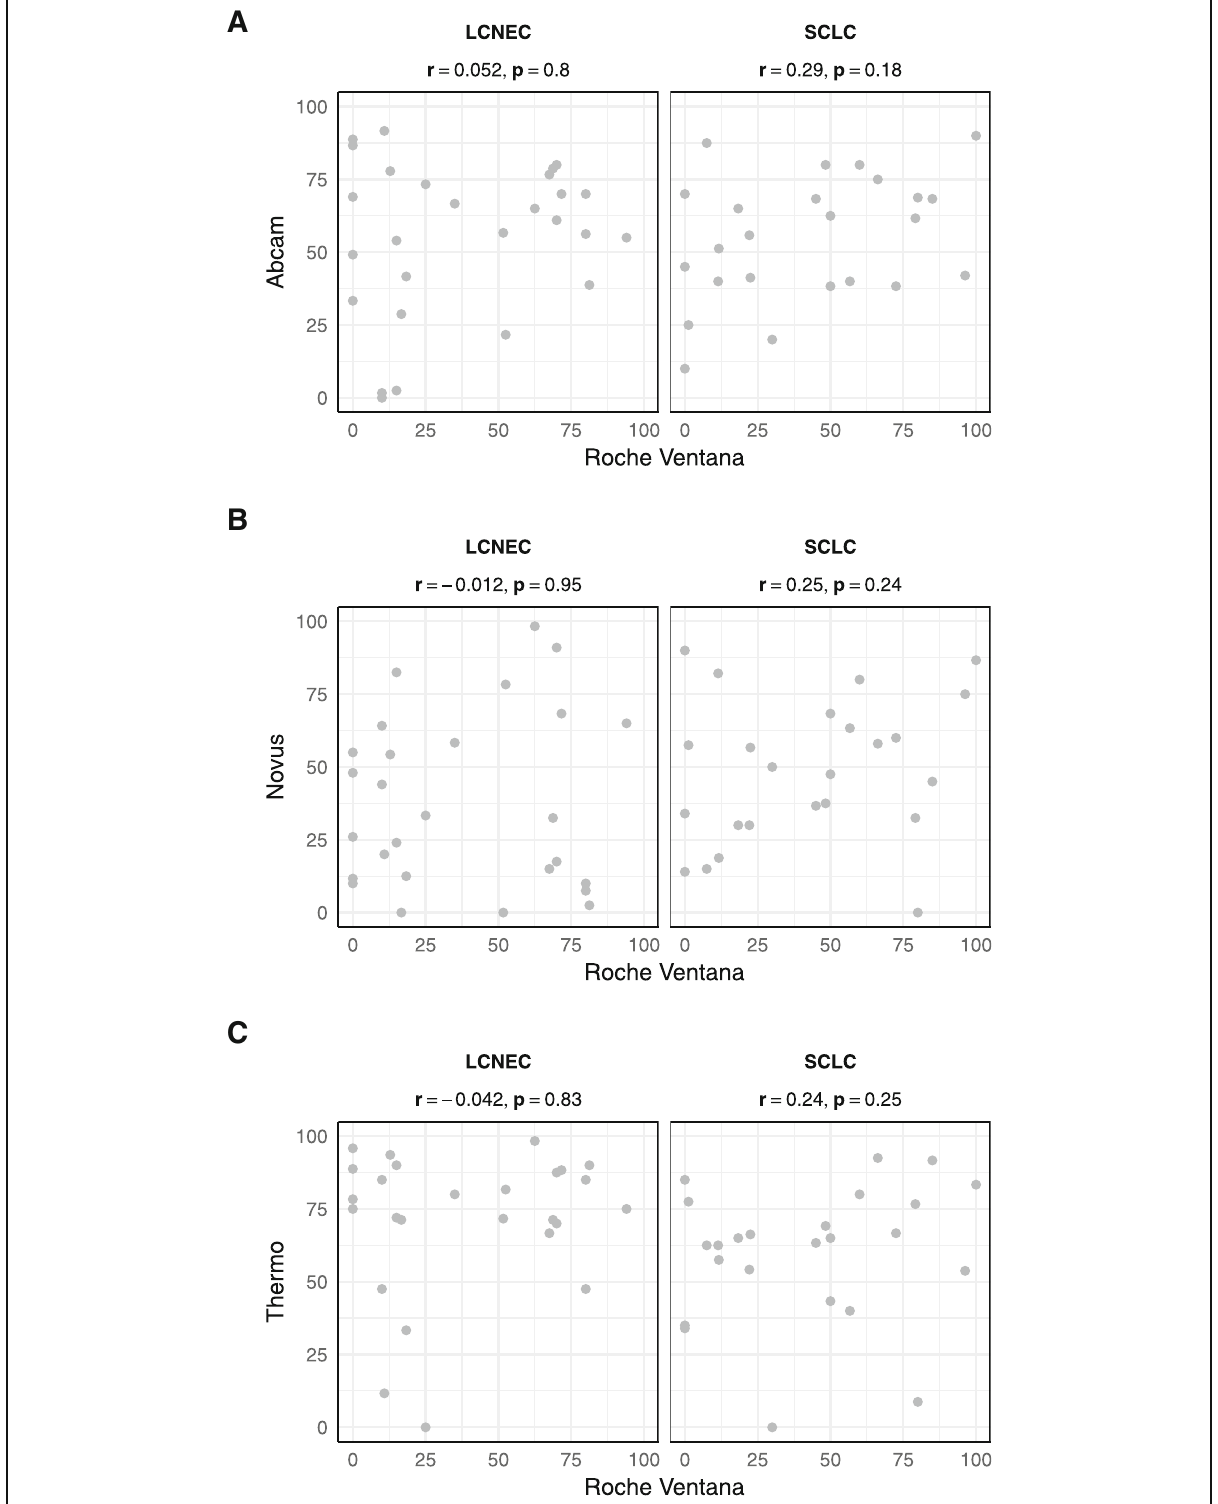
Fig. 1 Presentation of correlation of VenA tumor cell positivity in SCLC and LCNEC, with AbcA ( a ), NovA ( b ) and TherA ( c ), none of which was